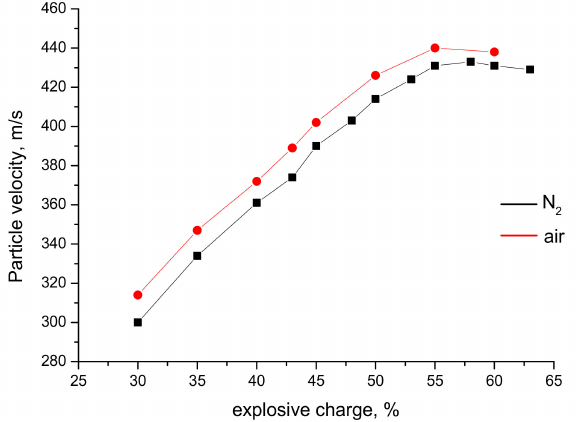
Figure 6. Calculated velocities of copper particles 40 µ m in size exiting the barrel of the detonation gun sprayed with di ff erent explosive charges using nitrogen and air as carrier gases (barrel length 1000 mm, barrel diameter 20 mm, k =